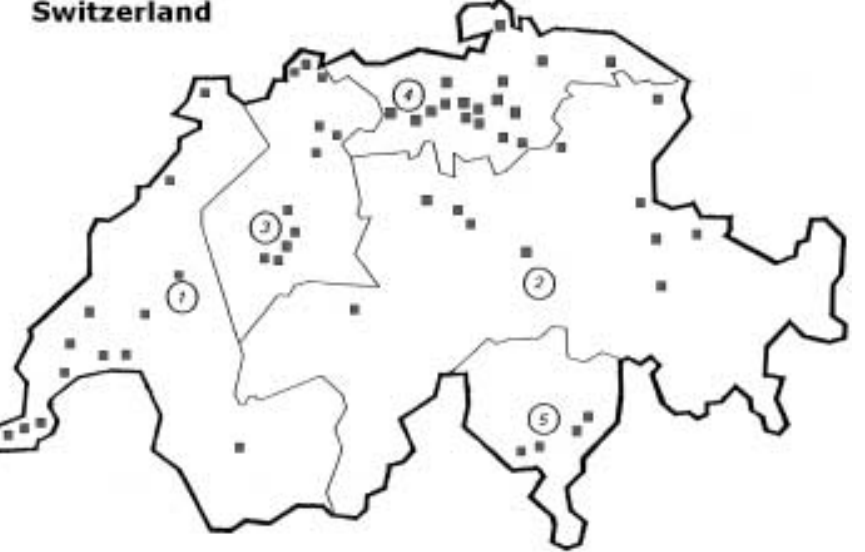
Map of Switzerland showing geographic regions and the loca- tion of the probabil- ity-proportionate- to-size sampling clus- ters (n =